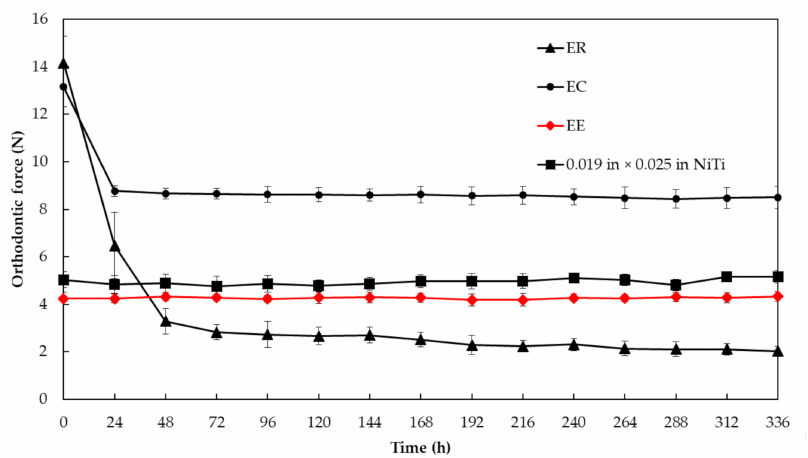
Figure 6. Orthodontic force measured from each